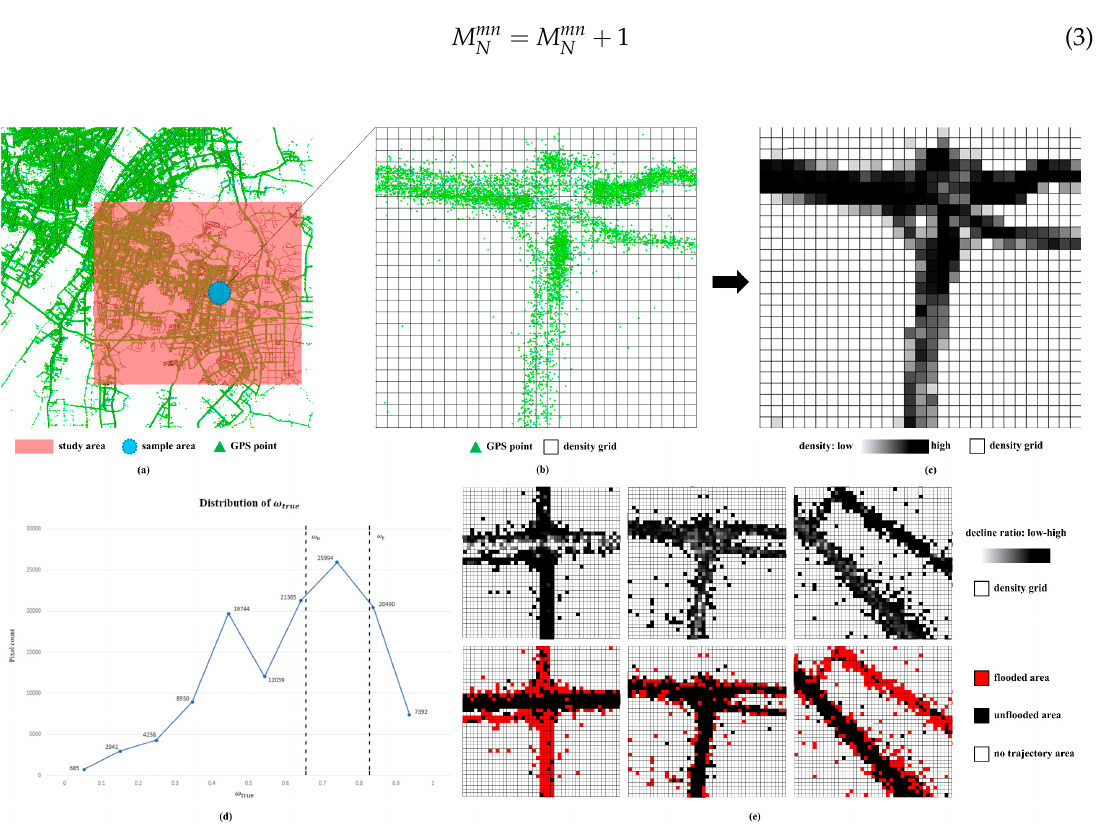
Figure 4. The process of extracting probable flooded areas. ( a ) The grid range based on vector road data and the location of example areas. ( b ) The GPS point distribution in example areas. ( c ) The density grid of example areas. ( d ) The distribution of the decline ratio ω true and the location of parameter 𝜔 (cid:3041) , 𝜔 (cid:3045) . ( e ) Grid contains probable flooded area using 𝜔 (cid:3045) in three different areas.